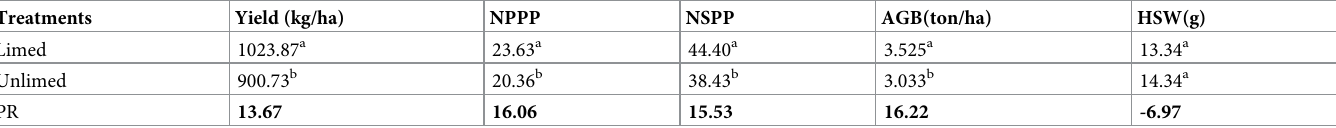
Means with the same letters are not significantly different at 5% level of significance. NPPP- Number of pod per plant; HSW = hundred seed weight, NSPP–Number of seed per plant; AGB- above ground biomass, PR = percent of